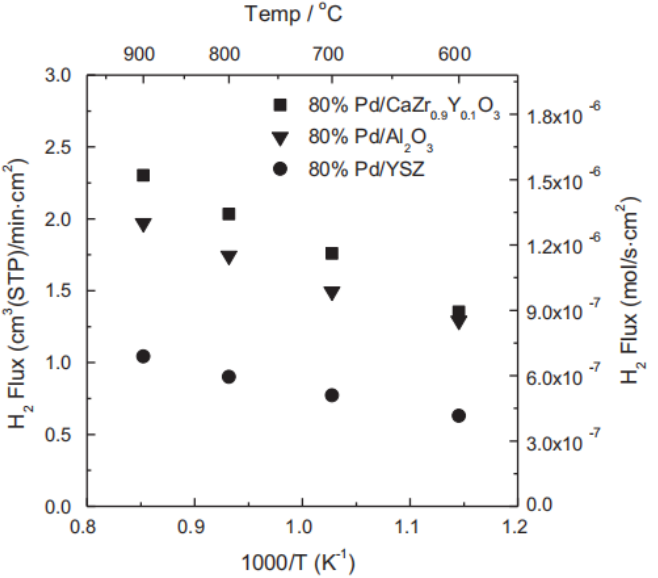
Figure 3. Three Pd-based cermet dual-phase membranes with different hydrogen permeation fluxes [34].